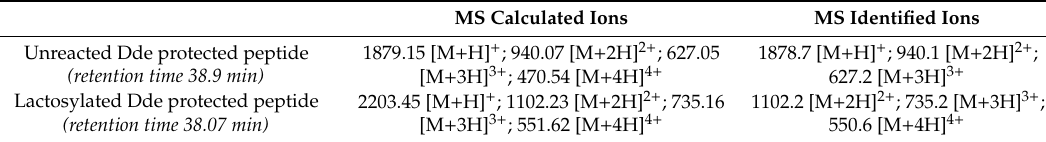
Table 7. MS ion of the synthesised peptide identified from the UPLC-MS